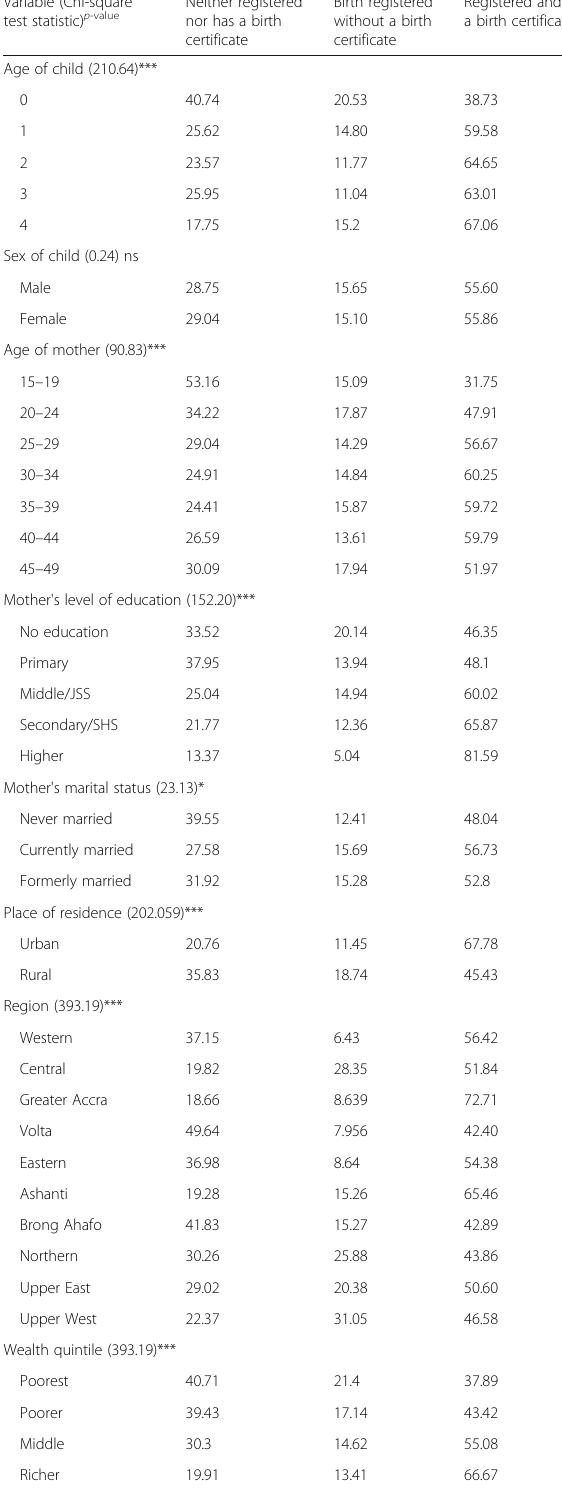
Table 2 Association between child and mothers ’ characteristics, geographic location and delivery characteristics by birth